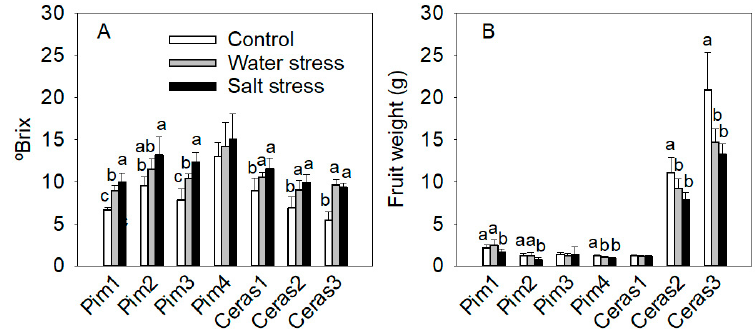
Figure 8 . Total soluble solids content (°Brix) ( A ) and fruit fresh weight (FW, g) ( B ) in accessions Pim1, Pim2, Pim3, Pim4, Ceras1, Ceras2 and Ceras3 under control, water stress and salt treatments after 4 months exposure. Data are mean values ± SE for n = 8 plants. Within each accession, different letters indicate significant differences at p < 0.05 (LSD test). Analysis of two-way ANOVA is provided in supplementary material in Table S7. SE: Standard error.